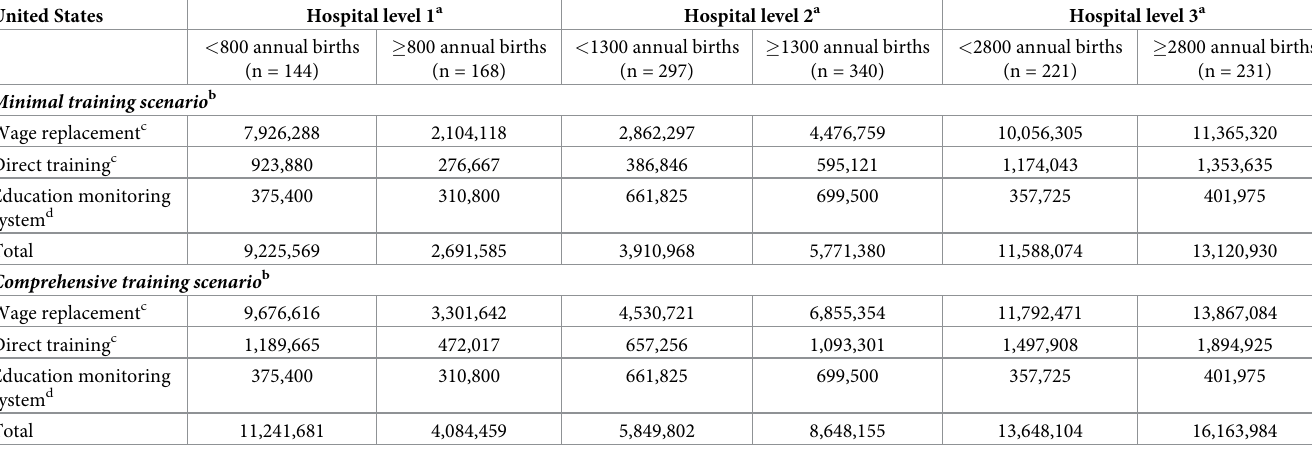
Table 6. First-year implementation cost estimates (in USD) for BFHI training in the United States (in USD) by obstetric level and hospital size. United States